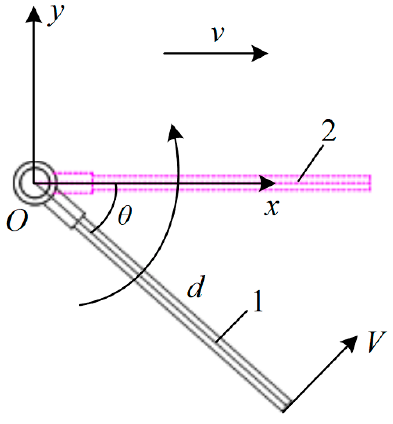
Figure 6. Movement track of dial rod.